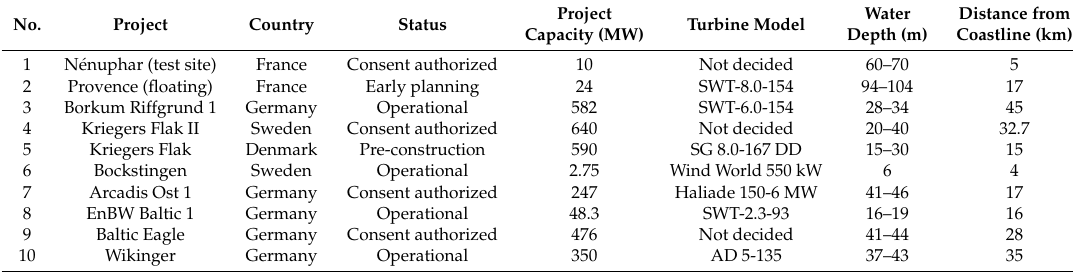
Figure 11. Direct comparison between the wind conditions reported close to reference point P2 and some European wind projects, where the dataset correspond to the AVISO measurements (September 2009–September 2017). The results correspond to: ( a ) U 80 comparison; and ( b ) main characteristics of the selected sites. Table 5. The European offshore wind projects considered for comparison